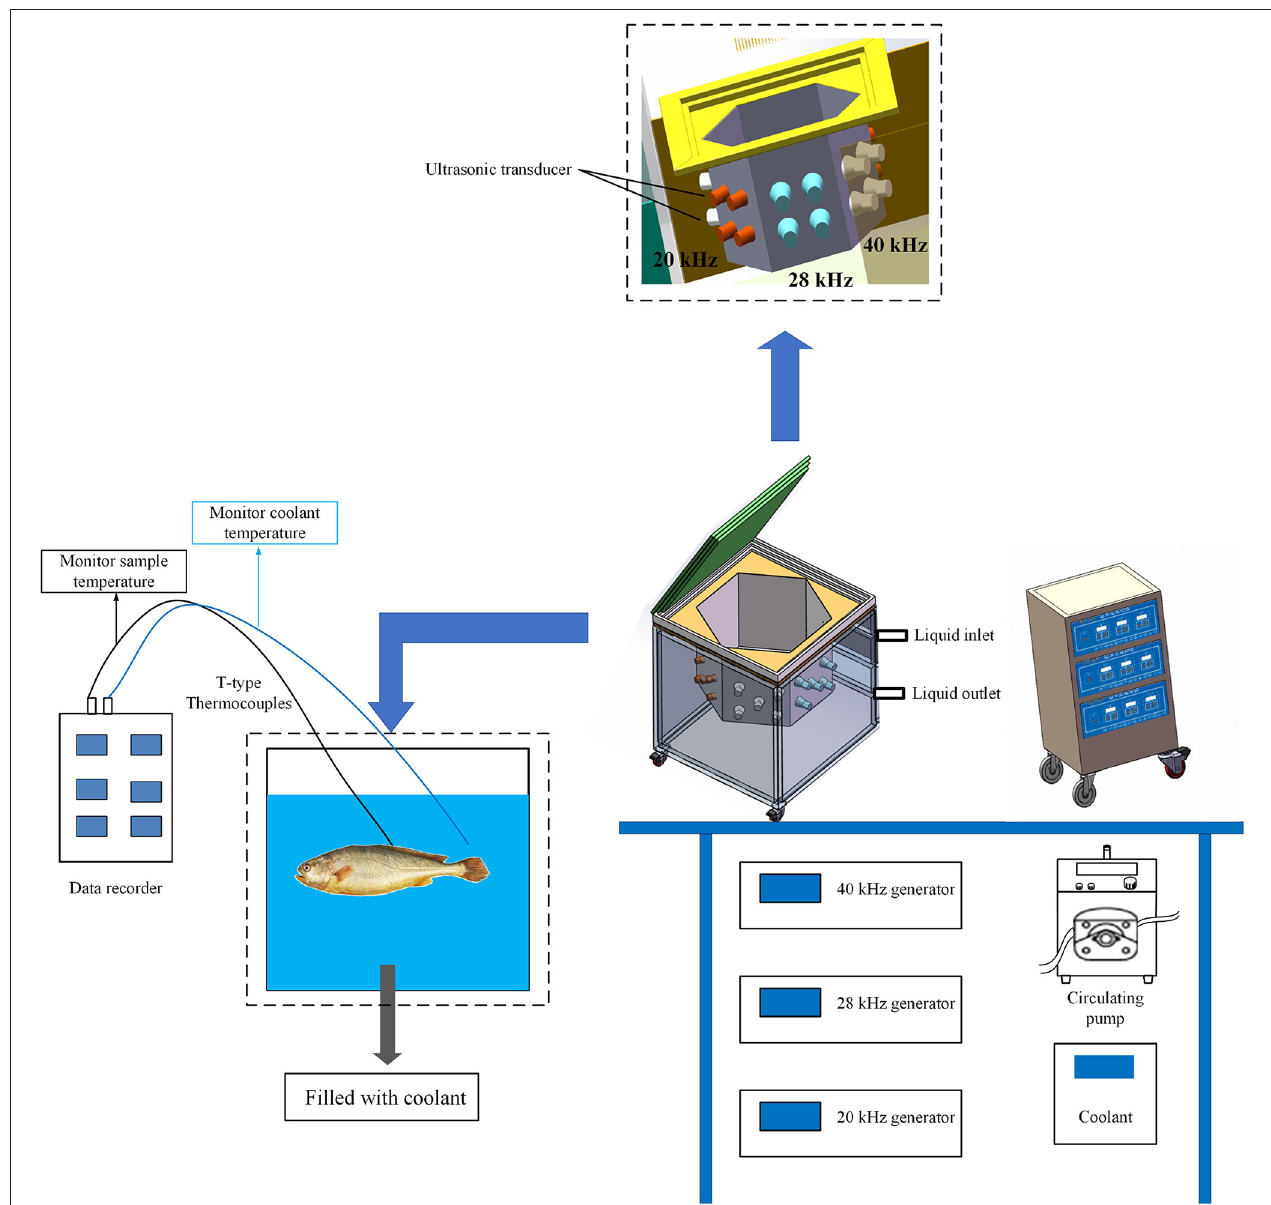
FIGURE 2 | The diagram of the multifrequency ultrasound-assisted immersion freezing unit.